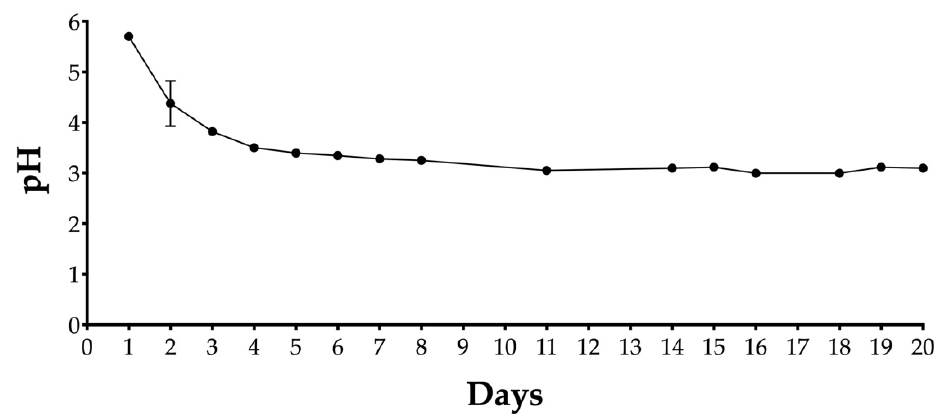
Figure 3. pH values detected over 20 days in pots used for growing M. polymorpha in liquid MS 1 / 2 medium, containing sucrose. Values are mean ± SE.